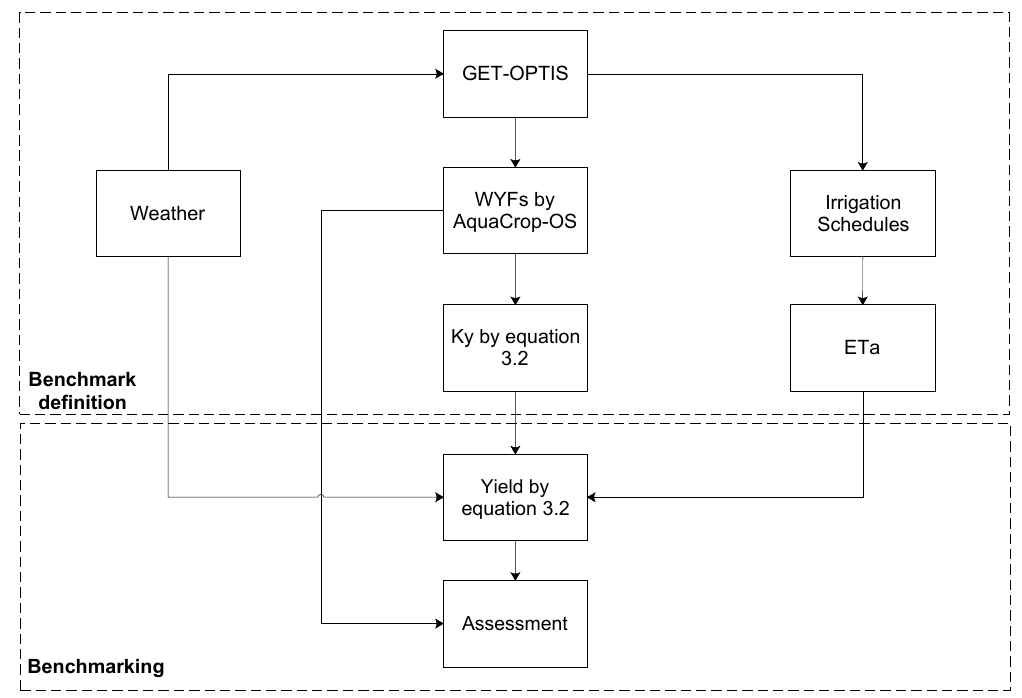
Figure 1. The methodology used for this research to estimate the Ky value at each growth stage under local conditions (i.e., for a given crop, soil, weather, sowing date, and management) using